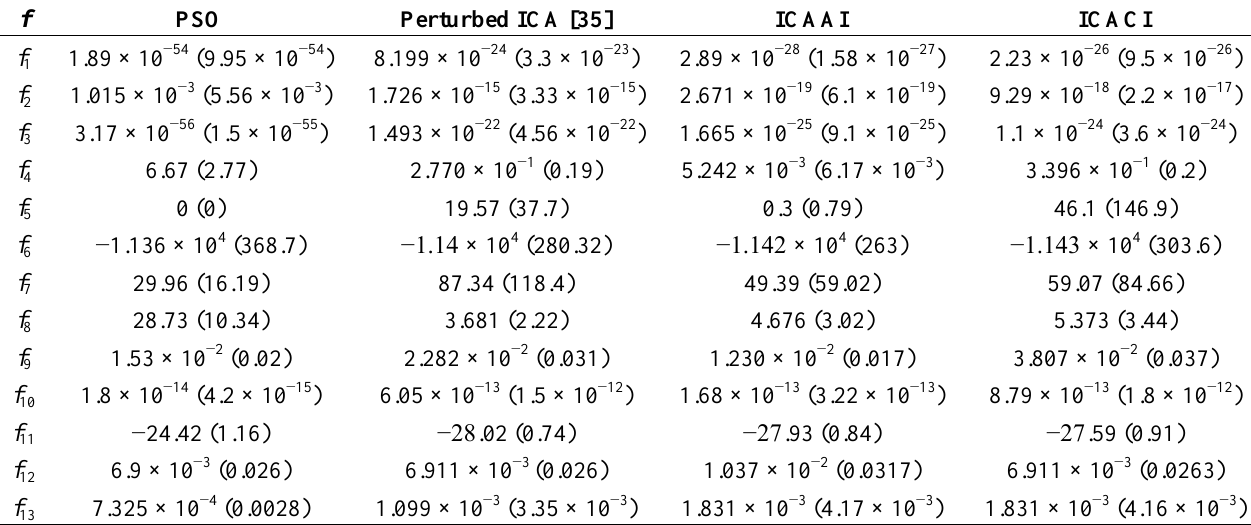
Table 3. Average and standard deviation of the best objective values over 30 runs after 3000 generations. The standard deviation is shown in